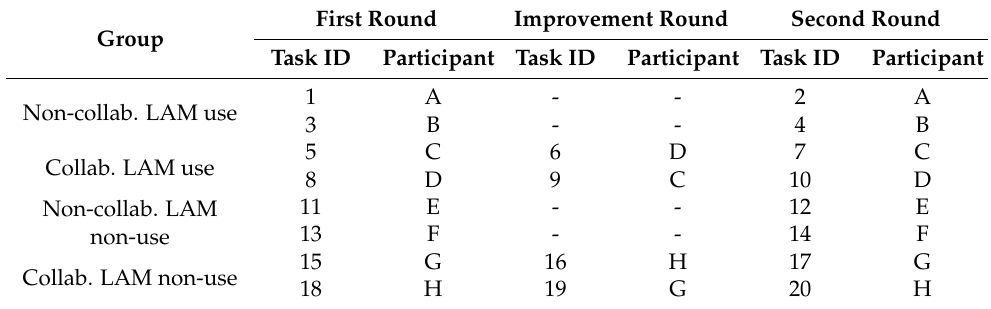
Table 1. Grouping of eight participants